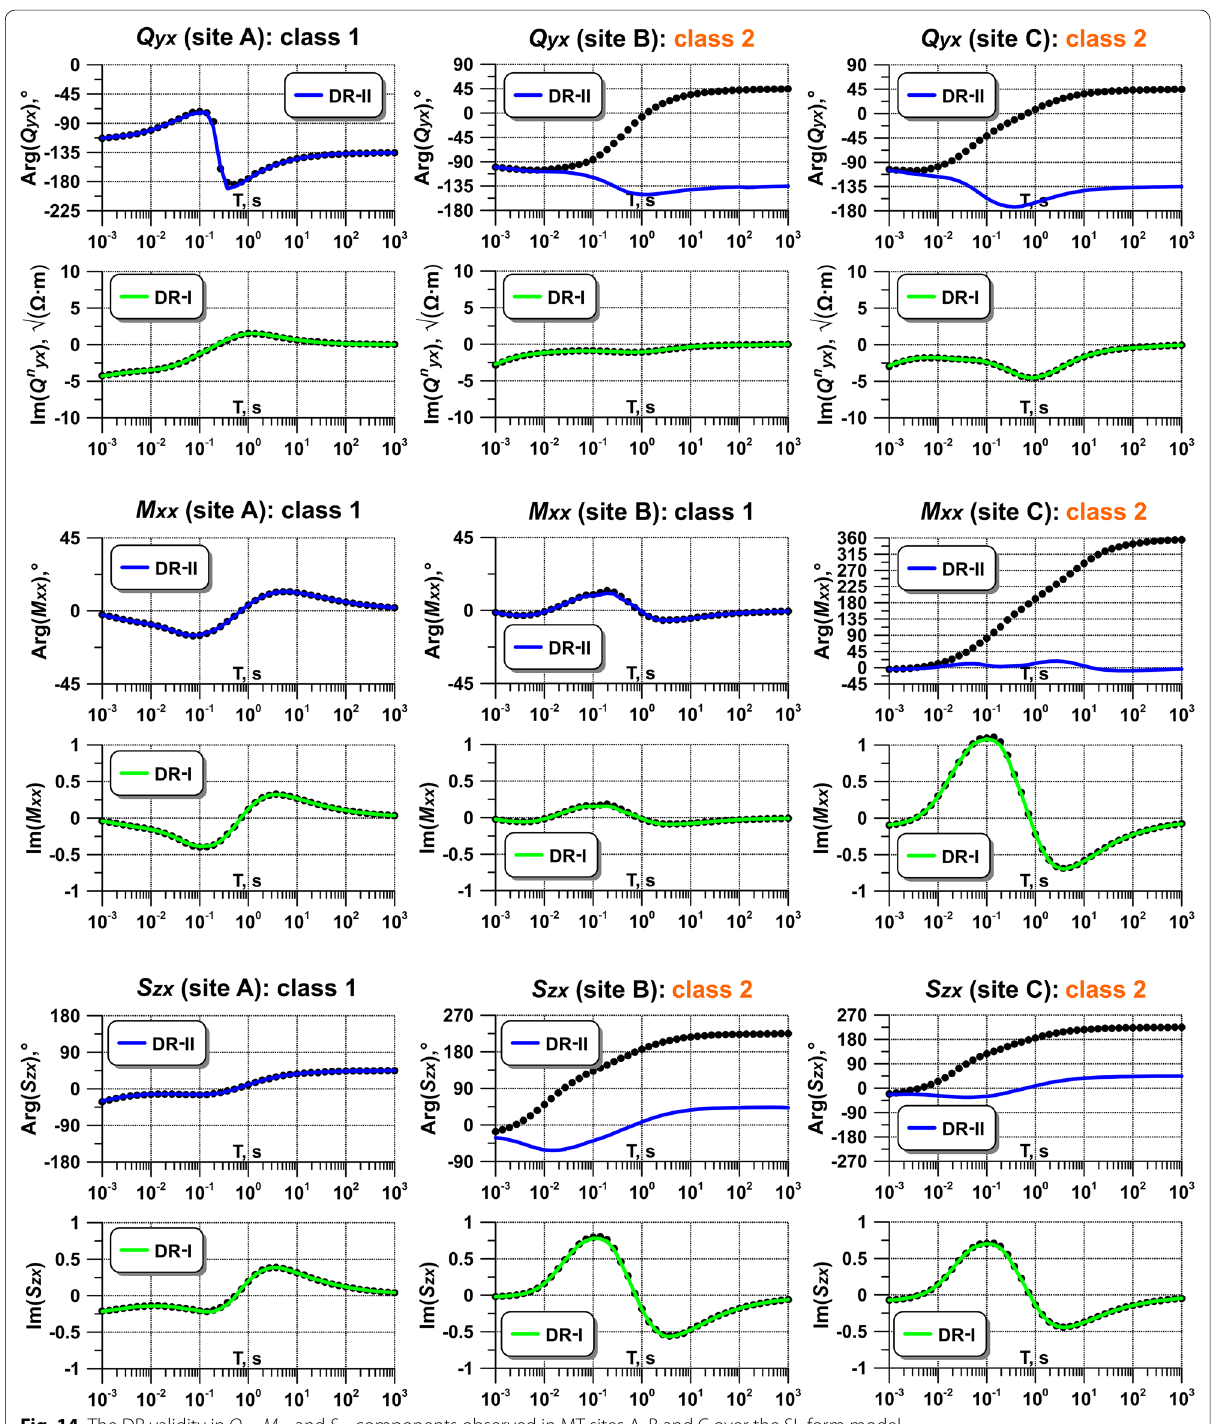
Fig. 14 The DR validity in Q yx , M xx and S zx components observed in MT sites A, B and C over the SL-form